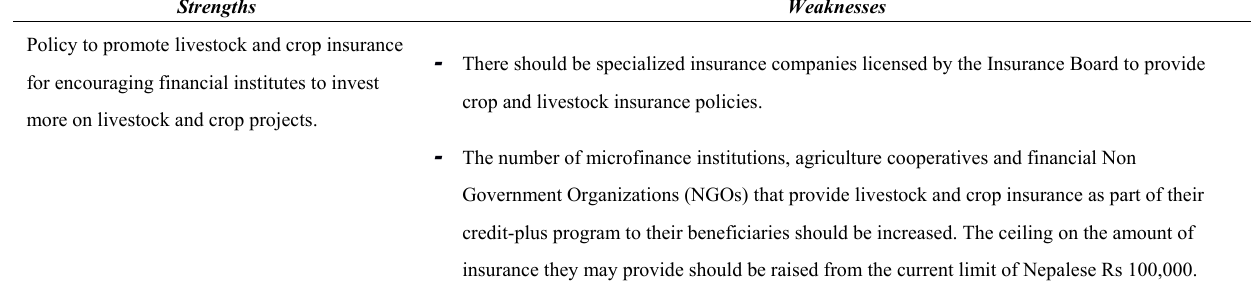
Table 4. SWOT Analysis of Livestock Insurance Policy.